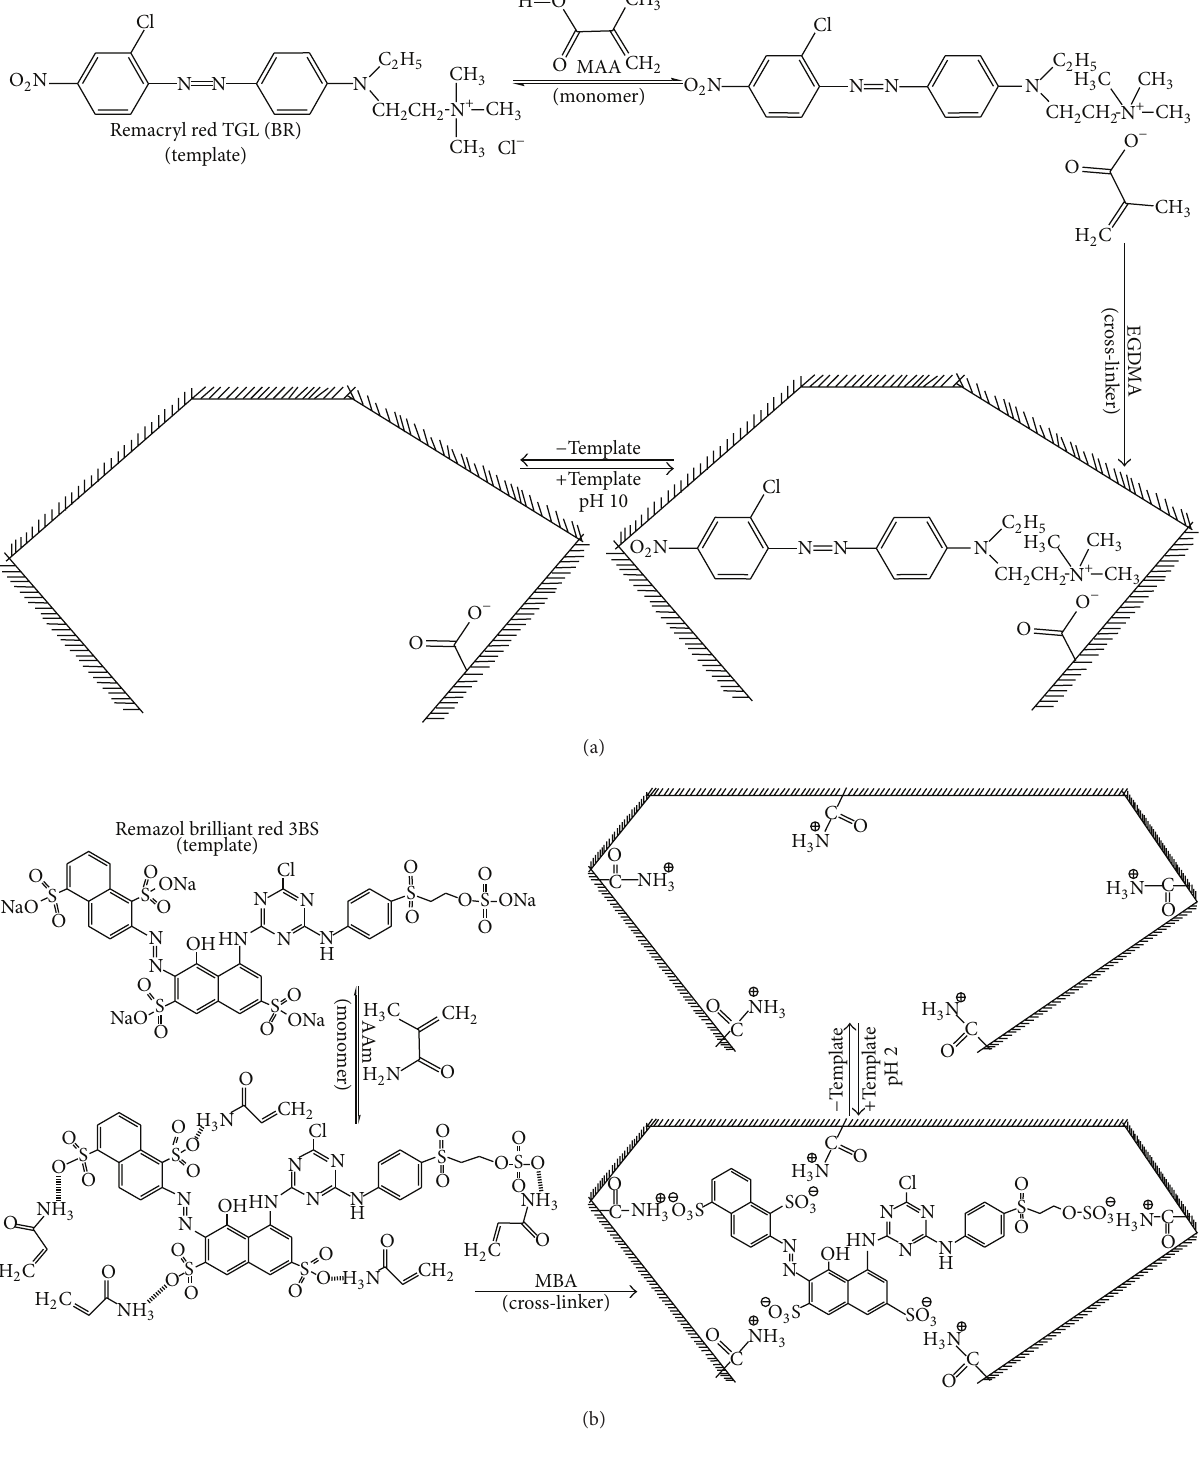
Figure 2: Schematic representation of the imprinting process for (a) basic and (b) reactive